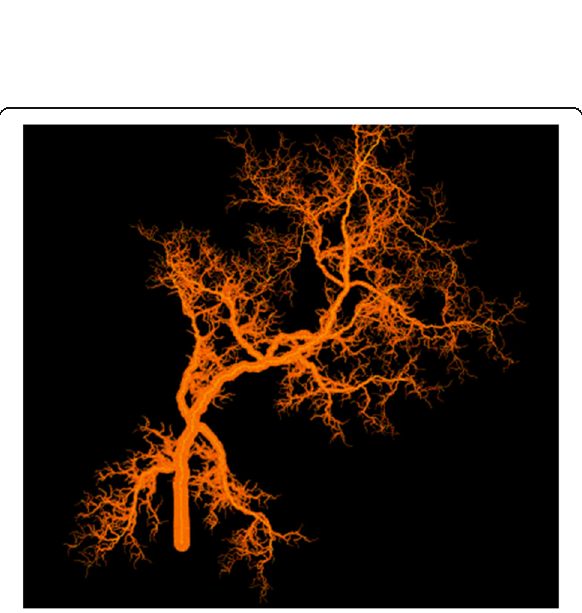
Fig. 6 Generation of fractal model of tumour microvasculature through FracLac